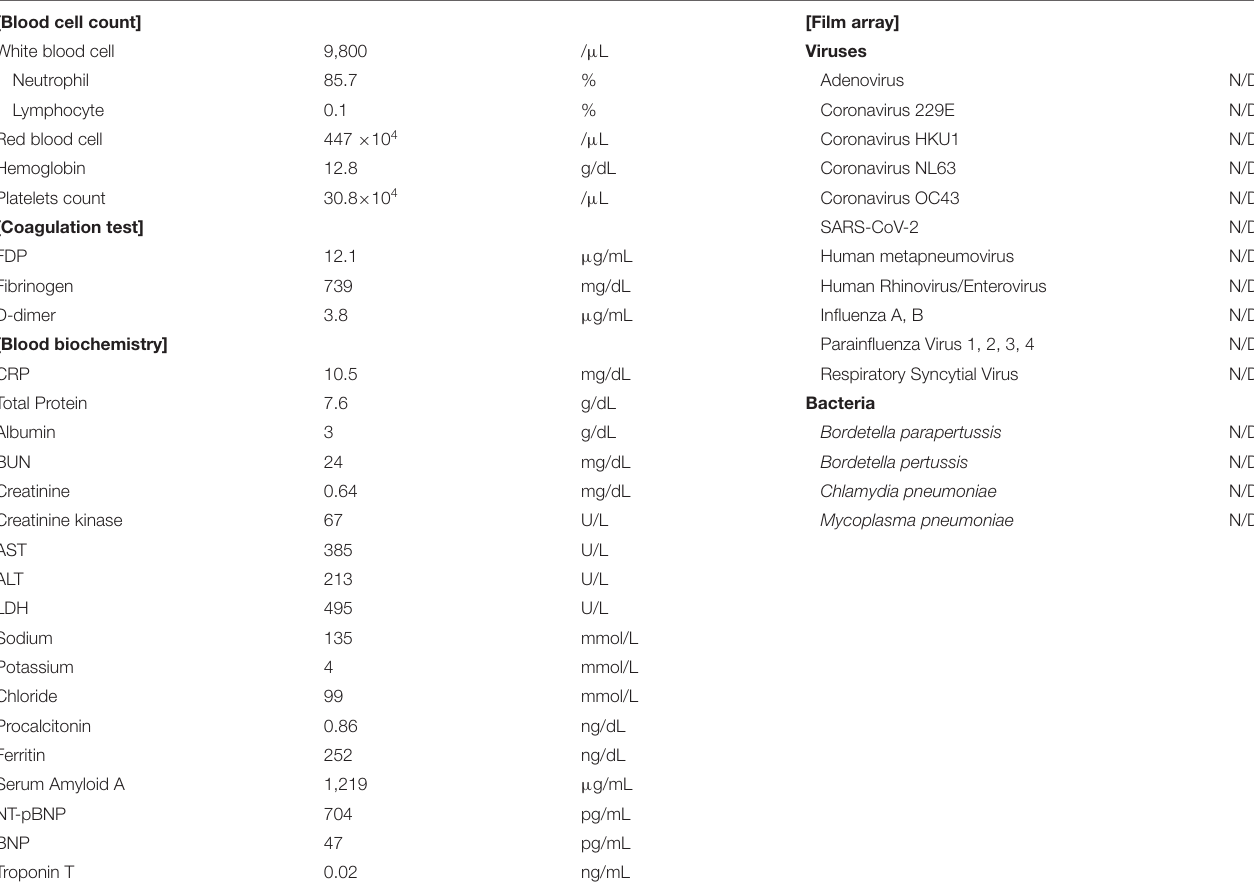
TABLE 1 | Laboratory test at